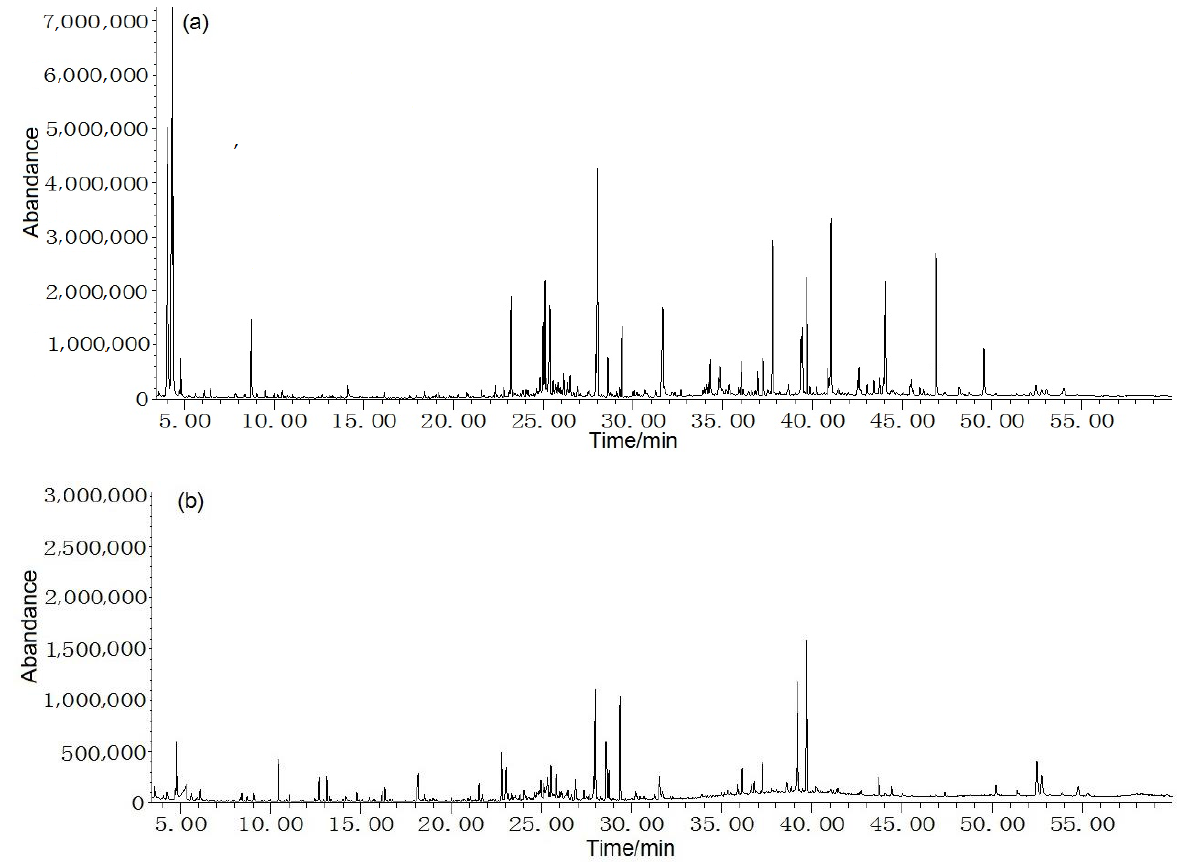
Figure 1. Total ion chromatogram from leaf ( a ) and stem ( b ) oils in F. japonicum . Table 1. Volatile compounds of leaf and stem from Farfugium japonicum.